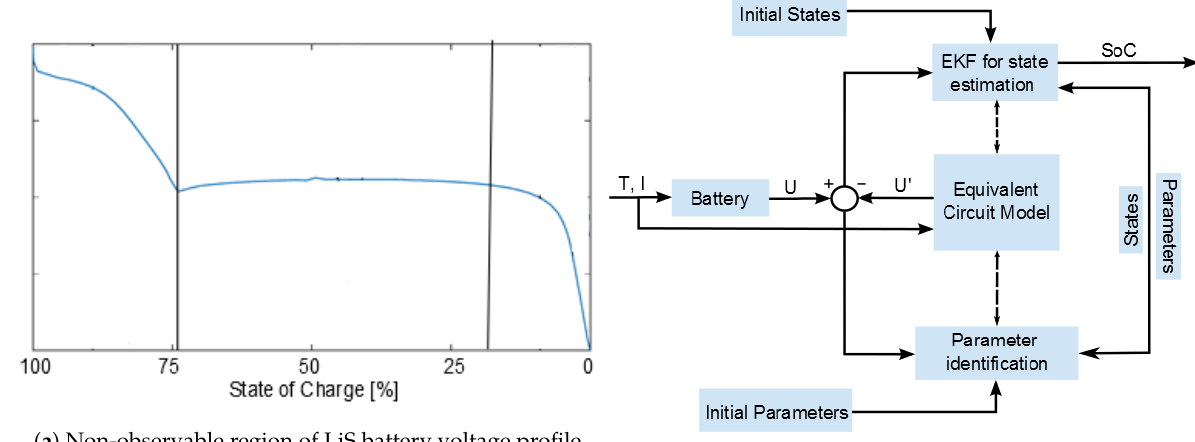
Figure 2. ( a ) LiS battery discharge voltage profile and ( b ) structure of Dual